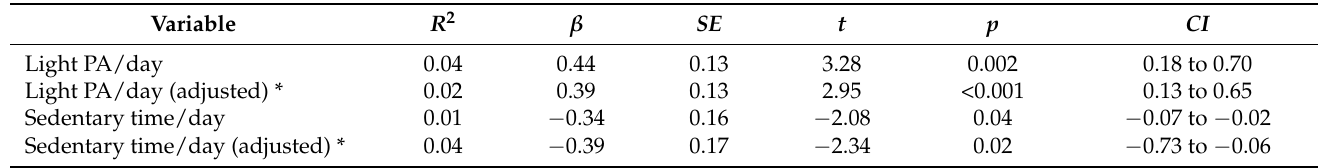
Table 3. Simple and multiple linear regressions examining effects of body image on average minutes of light PA/day and sedentary